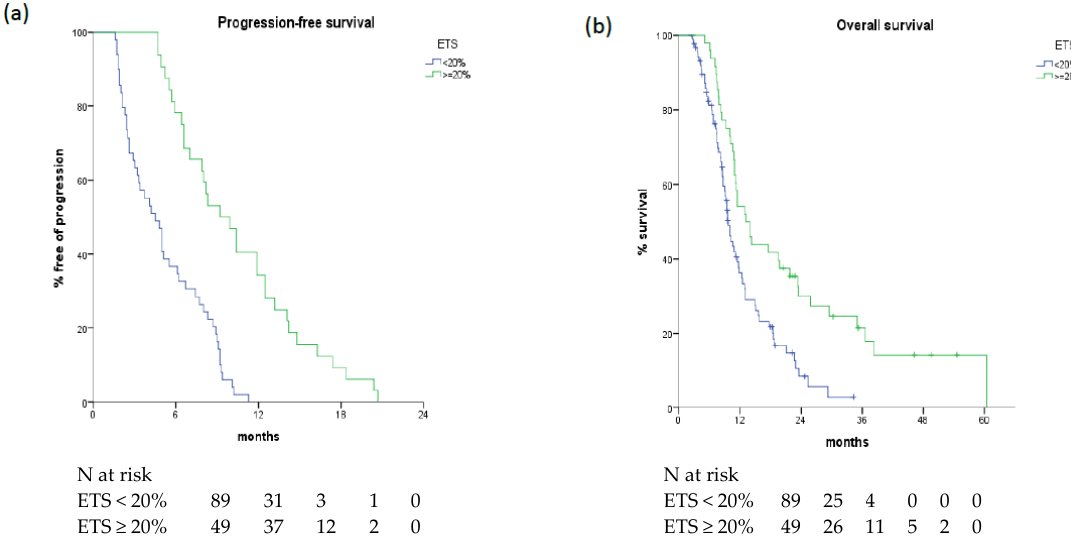
Figure 1. Progression-free survival ( a ) and overall survival ( b ) according to ETS values in overall population.